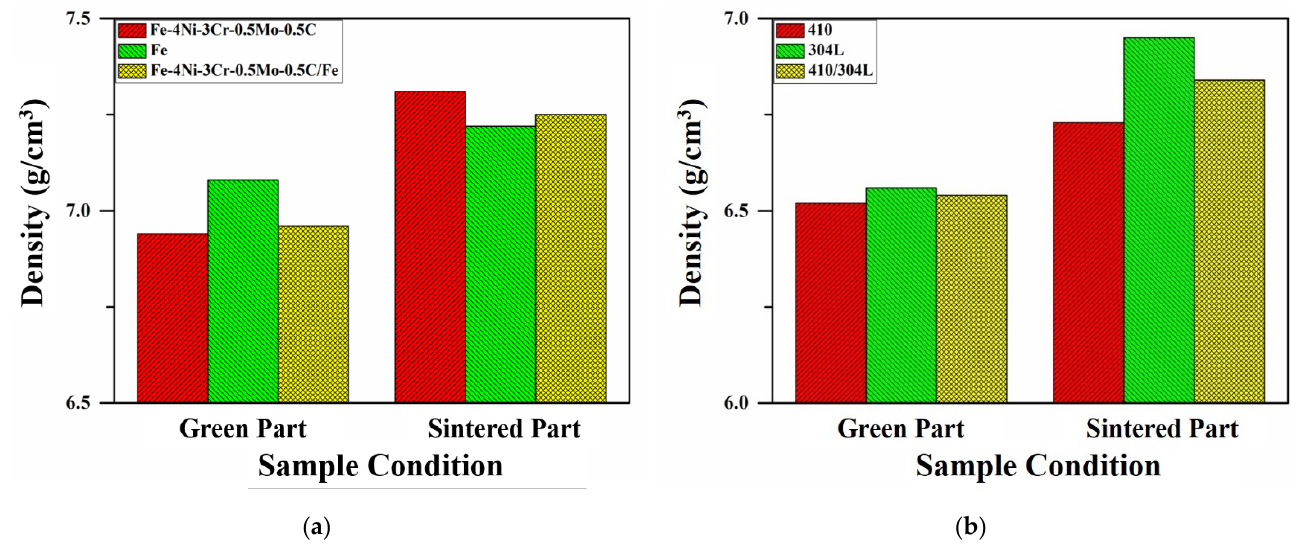
Figure 1. The green and sintered densities of the LMCs and the monolithic specimens. ( a ) Fe-4Ni-3Cr-0.5Mo-0.5C/Fe; ( b ) 410/304L.